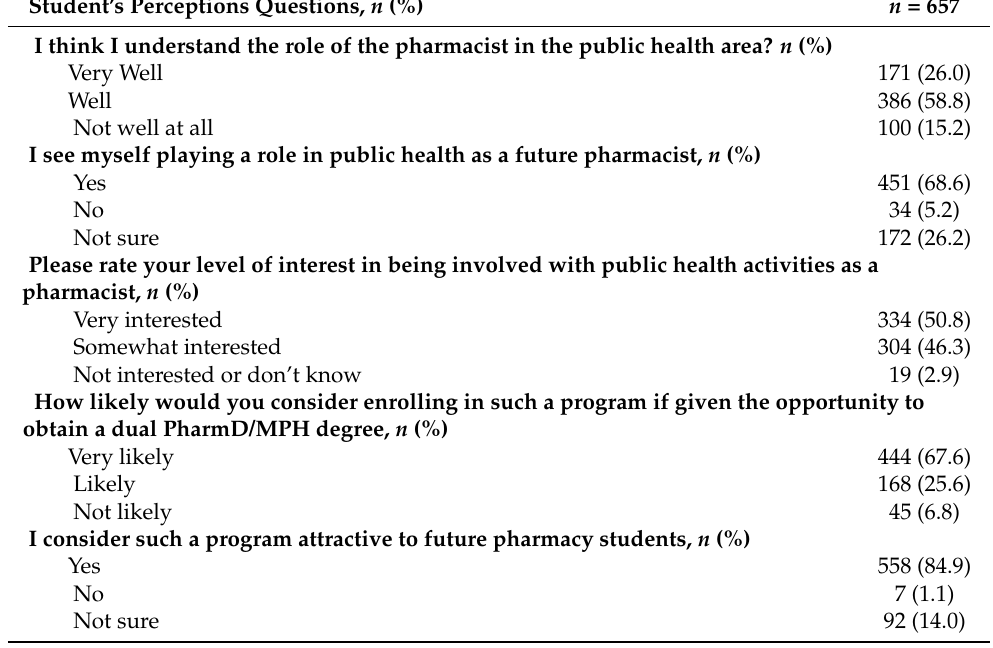
Table 2. The perception and likelihood of pharmacy students regarding a dual PharmD/MPH degree.